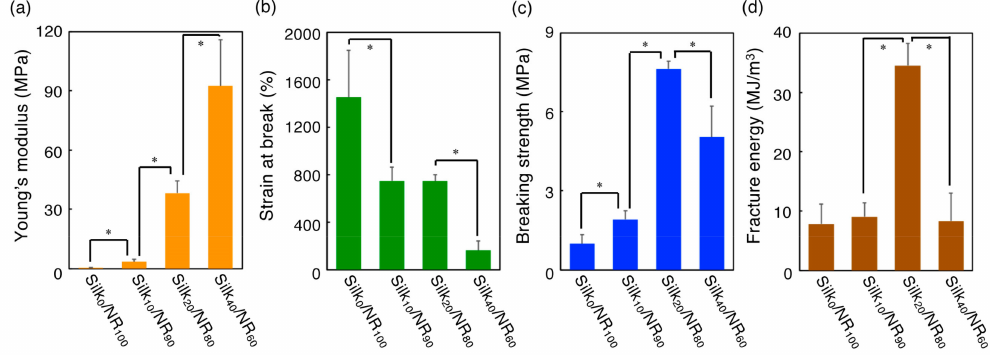
Figure 3. Mechanical properties of silk / NR composites with di ff erent silk contents: ( a ) Young’s modulus, ( b ) strain at break, ( c ) breaking strength, and ( d ) fracture energy. * Significant di ff erences between groups at p <